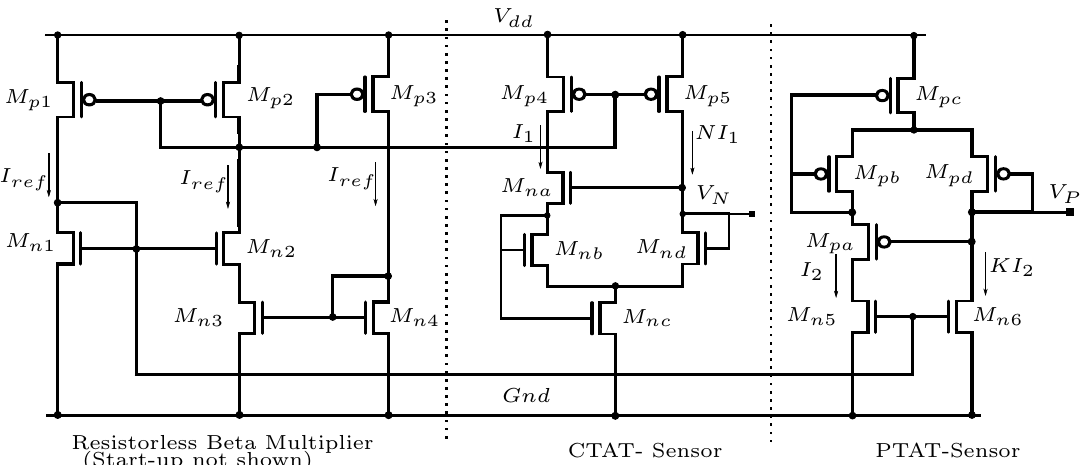
Figure 2. Circuit diagram of proposed temperature sensing